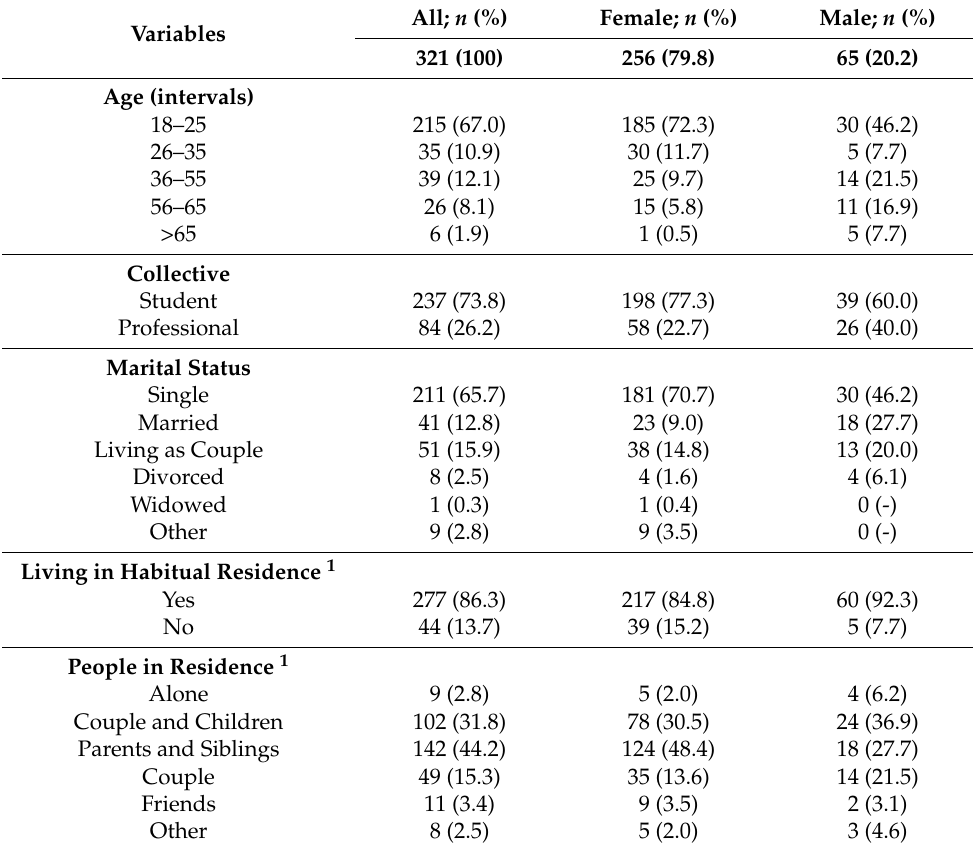
Table 1. Socio-demographic variables of the study